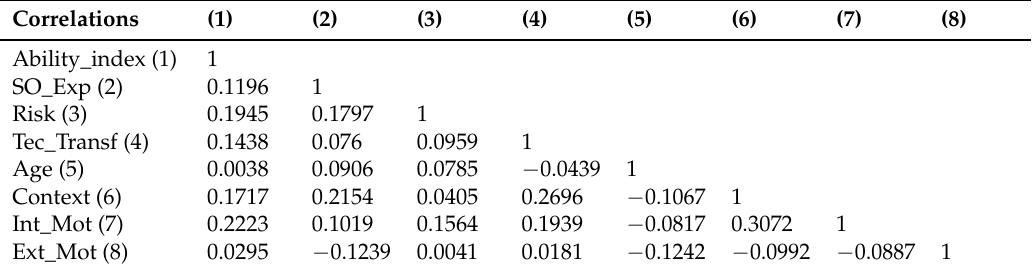
Table 5. Correlation matrix for the main covariates of the econometric analysis.